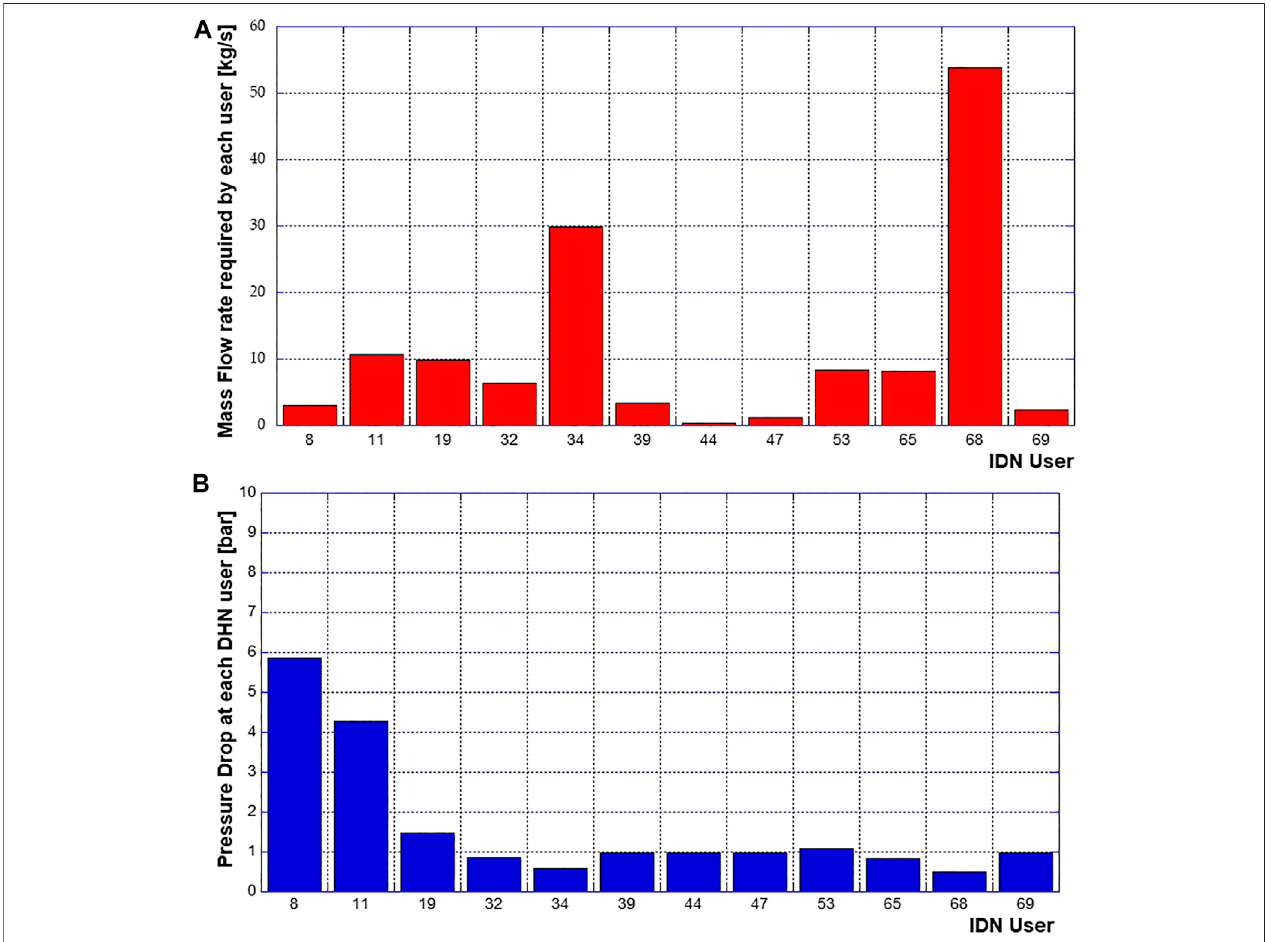
FIGURE 5 | (A) Mass fl ow rates and (B) pressure drops among the DHN users resulting from the design evaluation.